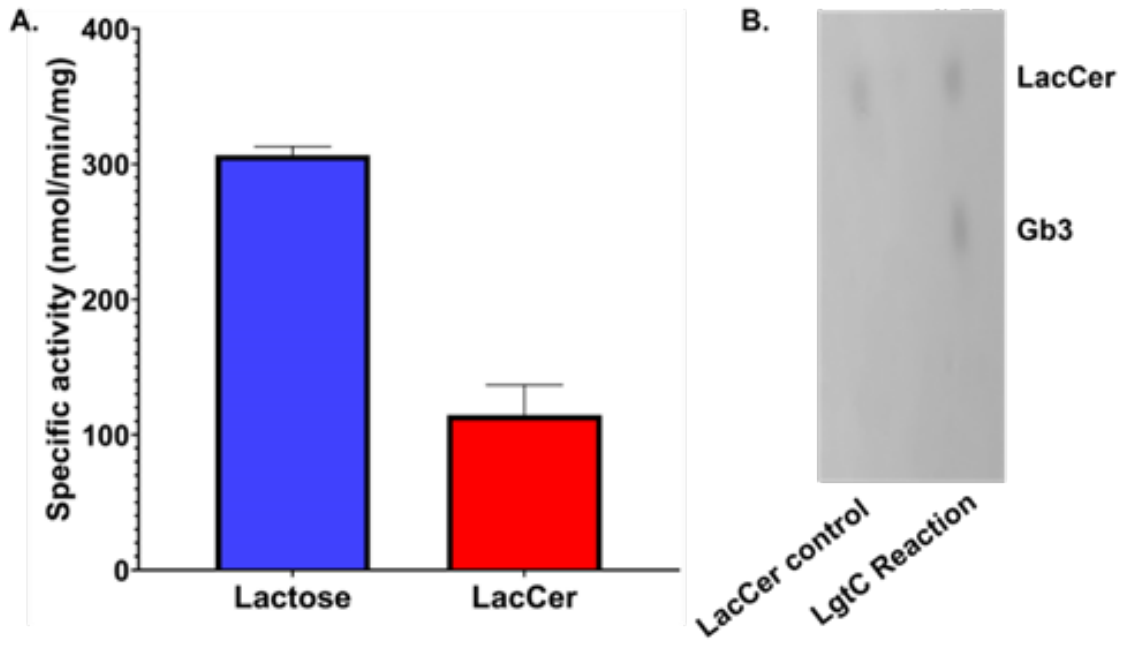
Figure 2. ( A ) LgtC activity on lactose and LacCer micelles. Conditions: 20 mM HEPES, pH 7.4, 1 mM MnCl 2 , 1 mM DTT, 100 µ M lactose or LacCer, 250 µ M UDP-Gal, 10 ng/ µ L (0.29 µ M) LgtC. ( B ) Thin layer chromatography analysis of Gb3 formation. The enzyme reaction was run for 12 h to maximize